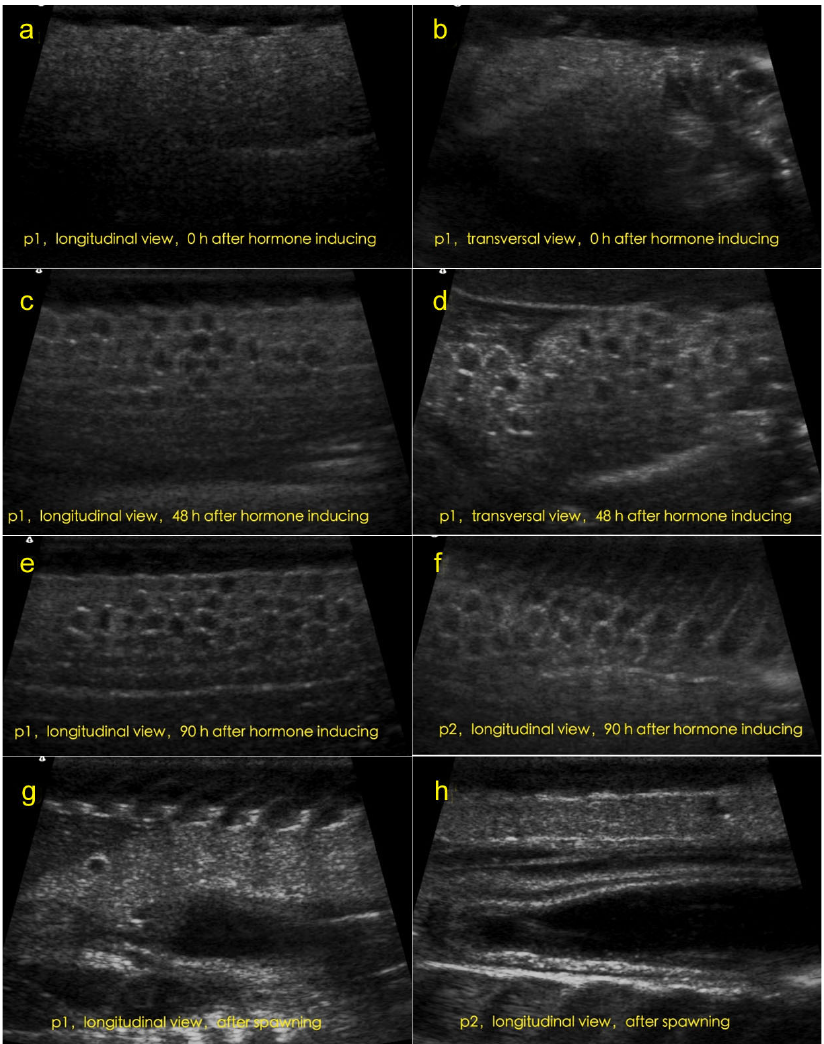
Figure 3. Ultrasound images of ovaries of mature Hucho bleekeri after hormonal induction. ( a,b ) 0h after hormonal induction; ( c,d ) 48h after hormonal induction; ( e,f ) 90h after hormonal induction; ( g,h ) after spawning.